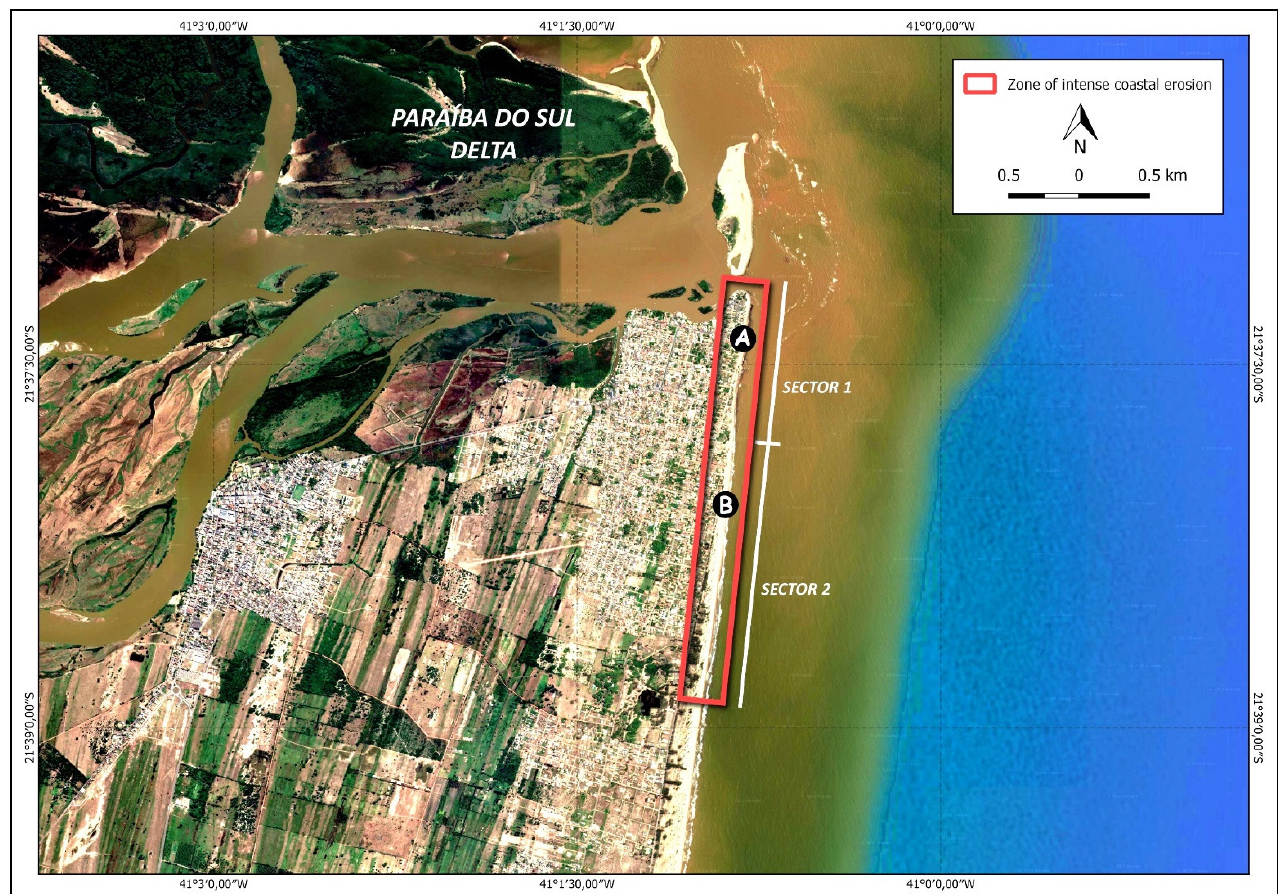
Figure 5. Zone of intense coastal erosion located south of the Paraíba do Sul River delta. Sector 1 of the red rectangle is characterized by the progressive loss of eroded urban structures that turned into emerged and submerged debris, while the central and lower sectors are characterized by the migration of foredunes over the continent. See Figure 6 for the photos related to A and B (black circles).